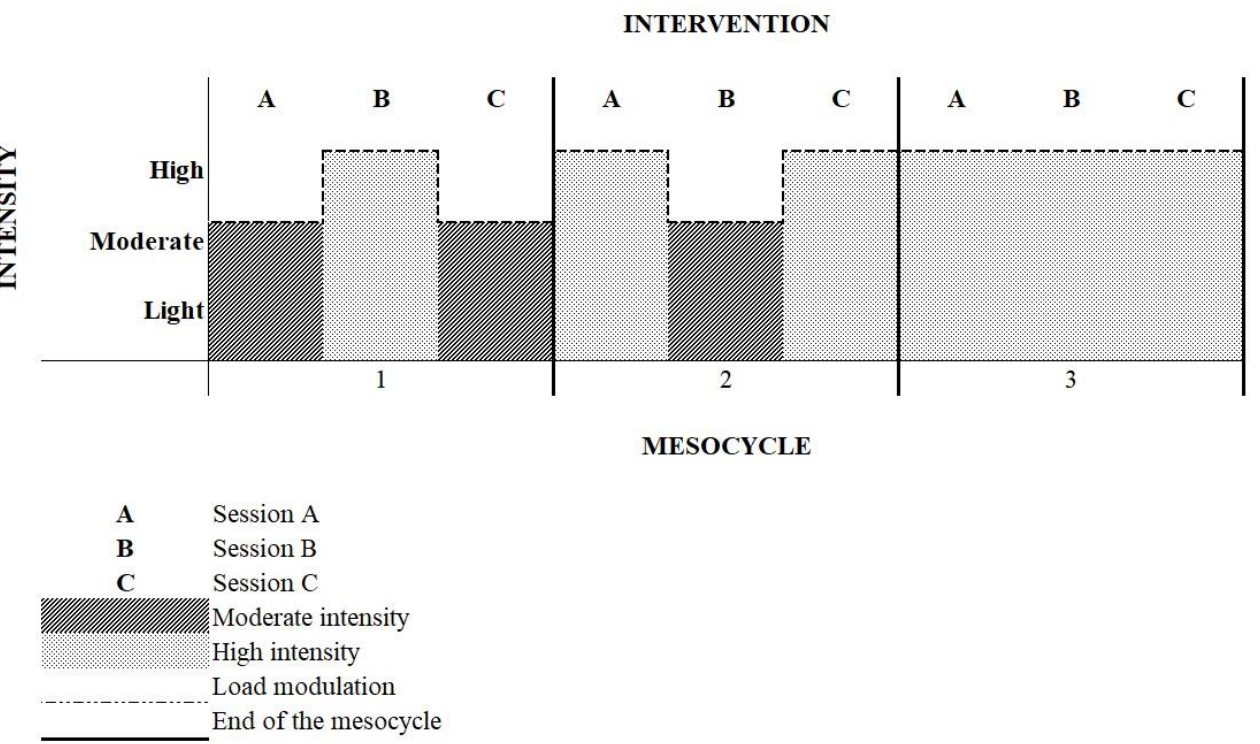
Figure 1. Intensity modulation during the nine weeks of training. The AT was performed using the interval method on treadmills (ICT) or on the running track (OCT), applying in both groups, the RPE method with the Borg scale of 6 to 20 (BORG, 1982) [26] to control the intensity. In the case of unfavorable weather conditions, AT